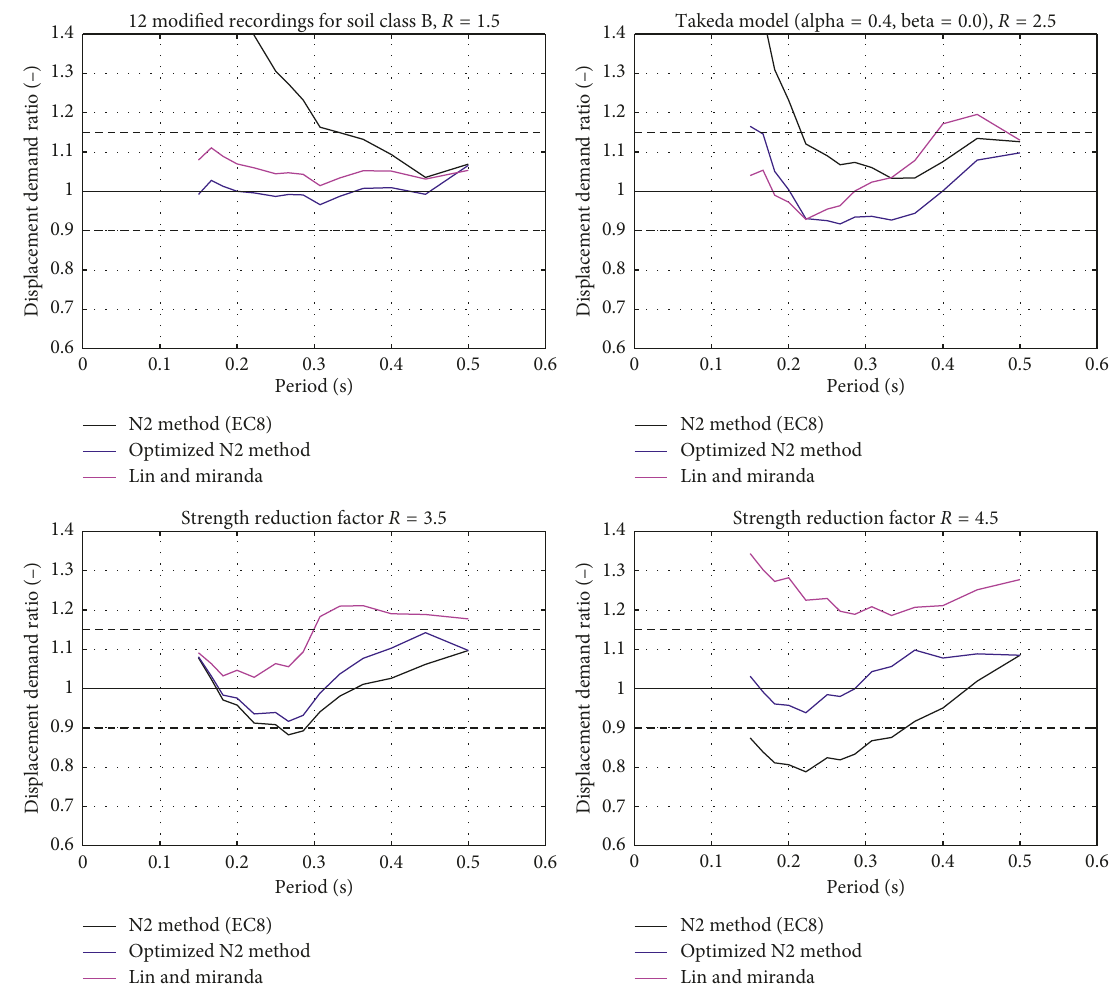
Figure 9: Assessment of the nonlinear displacement demands for soil class B and four values of strength reduction factors, R � 1 . 5 to R � 4 . 5. The ratio of predicted to actual (NLTHA) displacement demand is plotted with respect to the period. The plateau period range of the corresponding response spectrum (0.15s to 0.50s) is considered for the